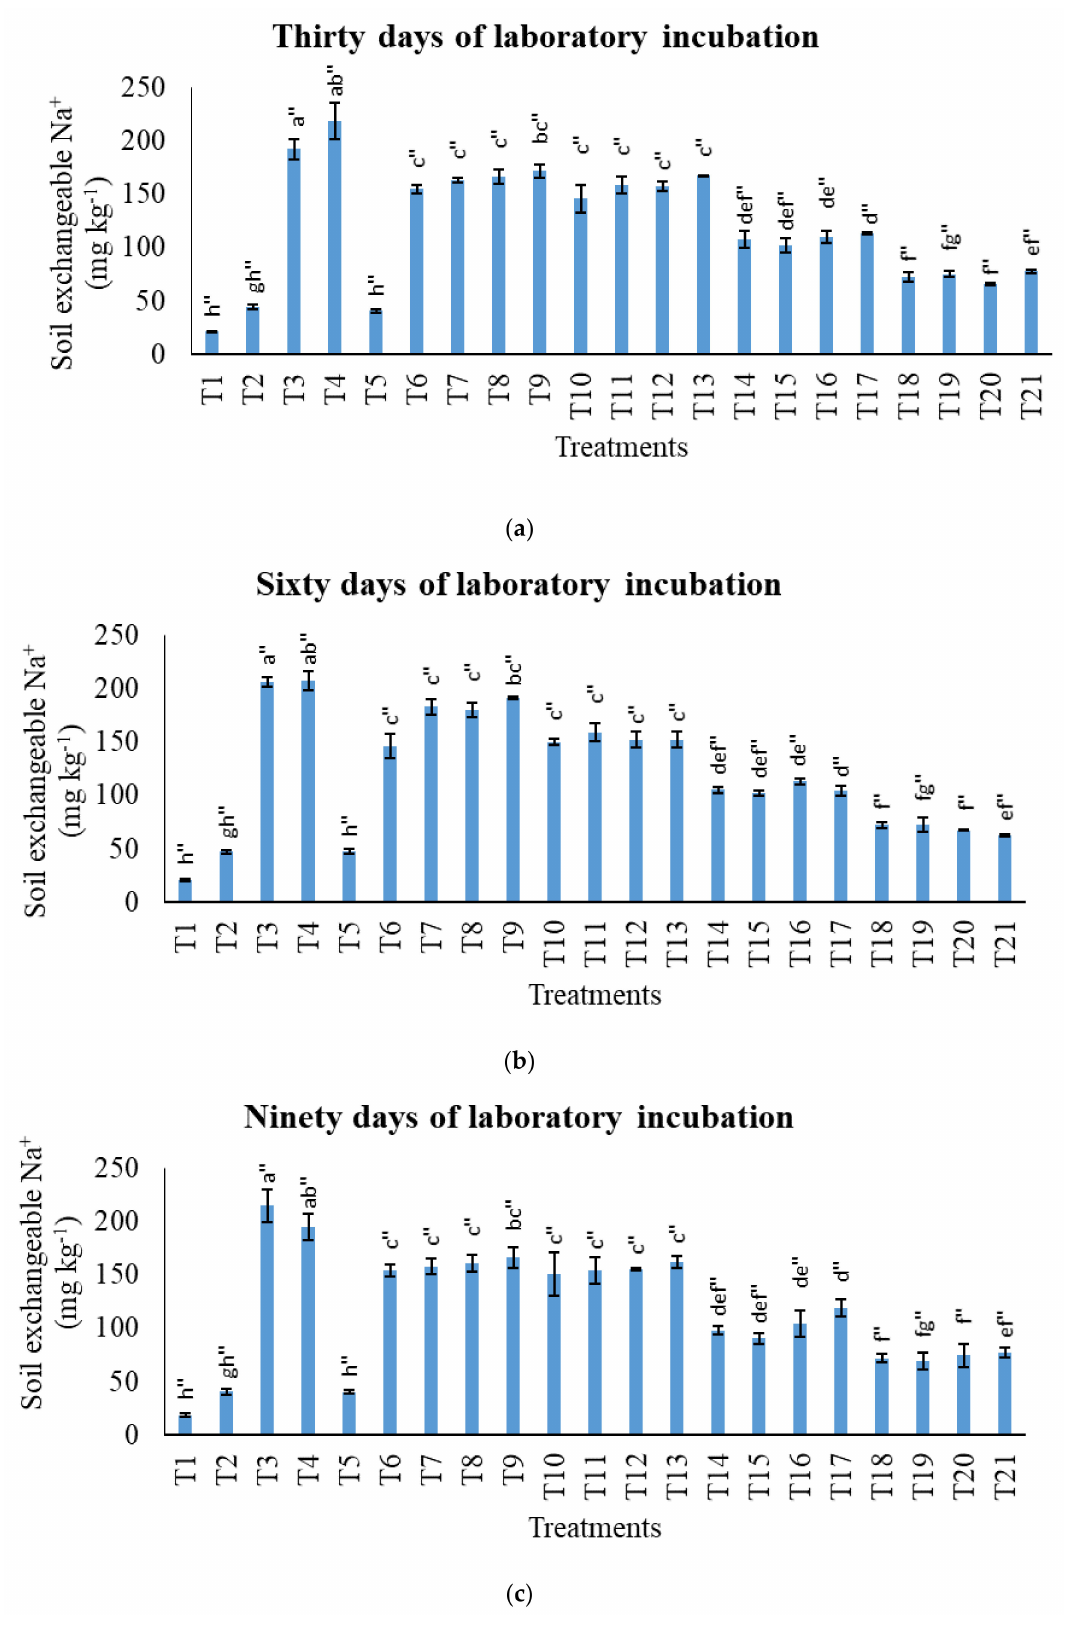
Figure 9. Effects of treatments on soil-exchangeable sodium over ( a ) thirty; ( b ) sixty; and ( c ) ninety days after incubation. T1: soil control, T2: conventional practice, T3: muriate of potash + 100% charcoal + 100% sago bark ash, T4: muriate of potash + 100% sago bark ash, T5: muriate of potash + 100% charcoal, T6: muriate of potash + 80% charcoal + 80% sago